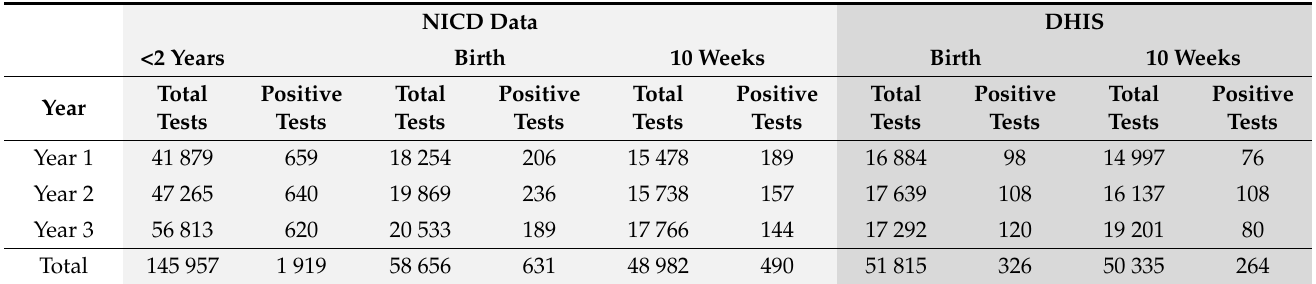
Table 1. Comparison of NICD and DHIS HIV PCR tests performed and positive tests